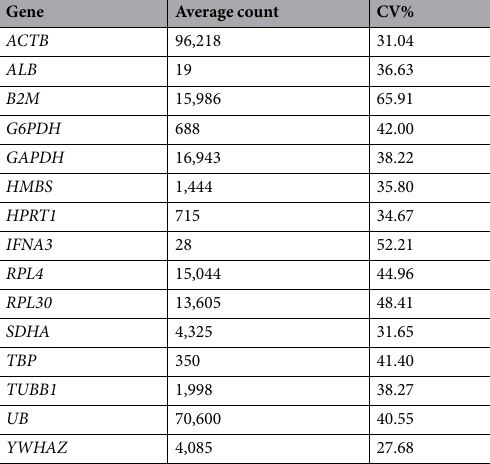
Table 2. Average count and CV% from NanoString for 15 candidate reference genes. Results from three biological replicates (n = 3). One biological replicate of each sample consisted of IEL-28.4 + cells harvested from 8